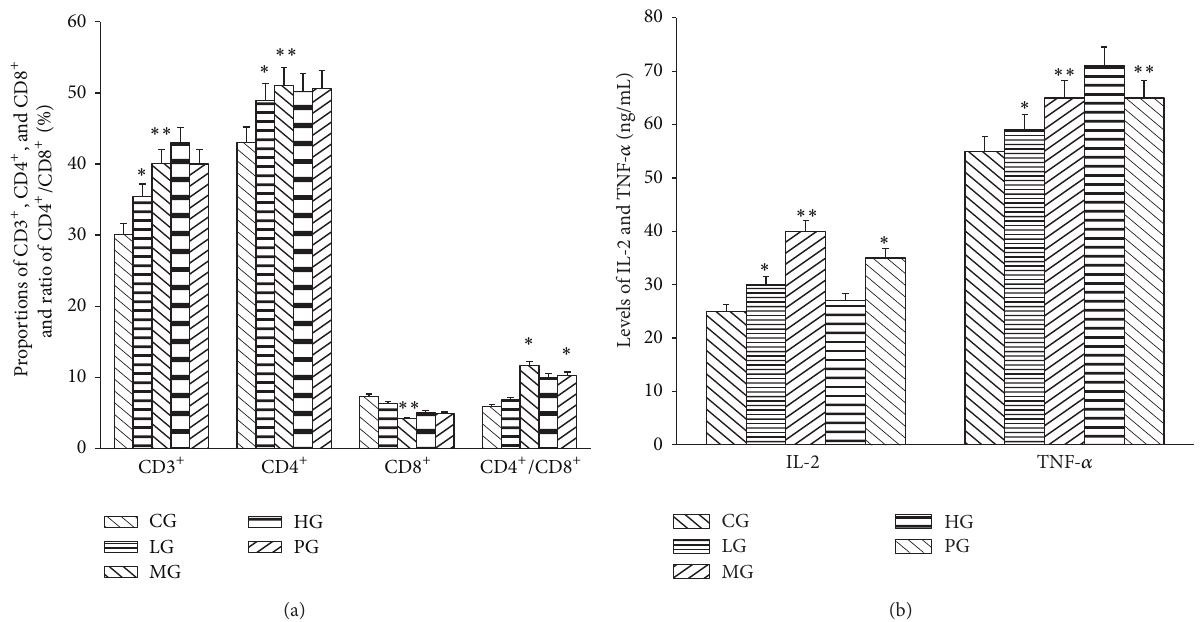
Figure 4: Effects of PFVM on T lymphocyte subpopulation (a), levels of IL-2 and TNF- 𝛼 (b) in mice spleen lymphocytes. CG, control group; LG, low dose group; MG, medium dose group; HG, high dose group; PG, positive control group. ∗ 𝑃 < 0.05 , ∗∗ 𝑃 < 0.01 versus control